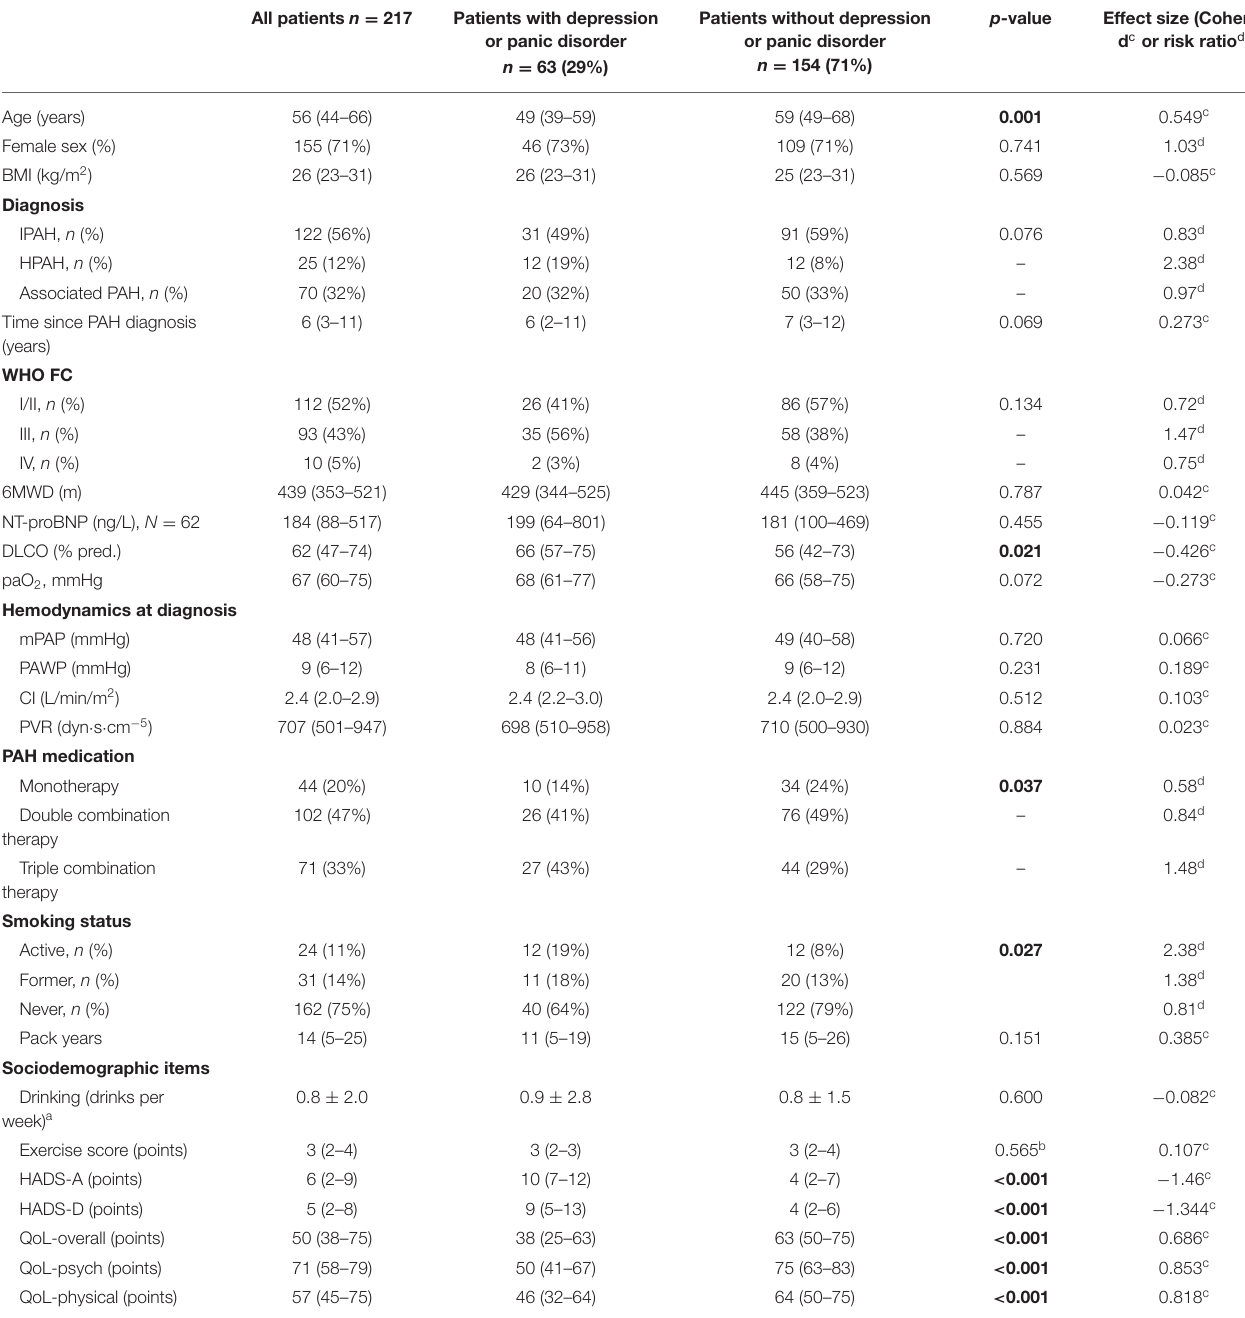
TABLE 1 | Characteristics of the patients at baseline. All patients n = 217 Patients with depression Patients without depression or panic disorder or panic